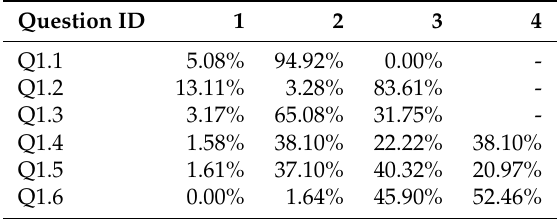
Table 8. Answers of the survey preformed at the first class.